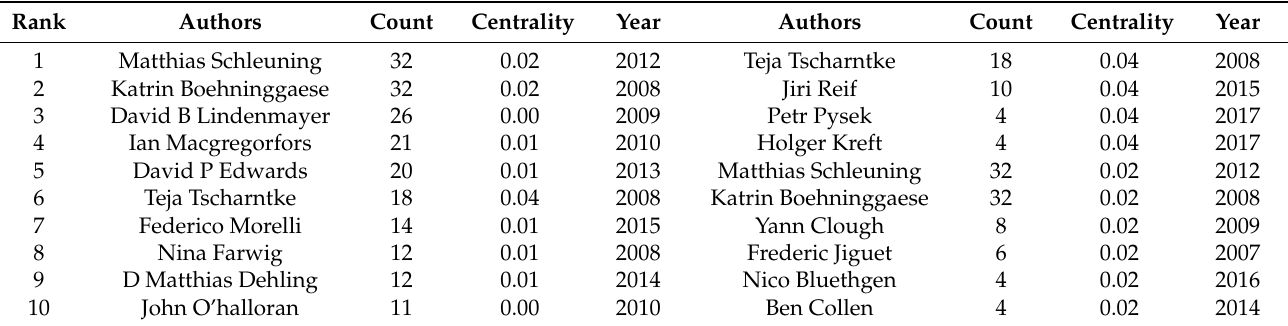
Figure 2. Author collaboration network map. Table 2. The 10 authors with the highest total number and concentration of research papers published in the study.